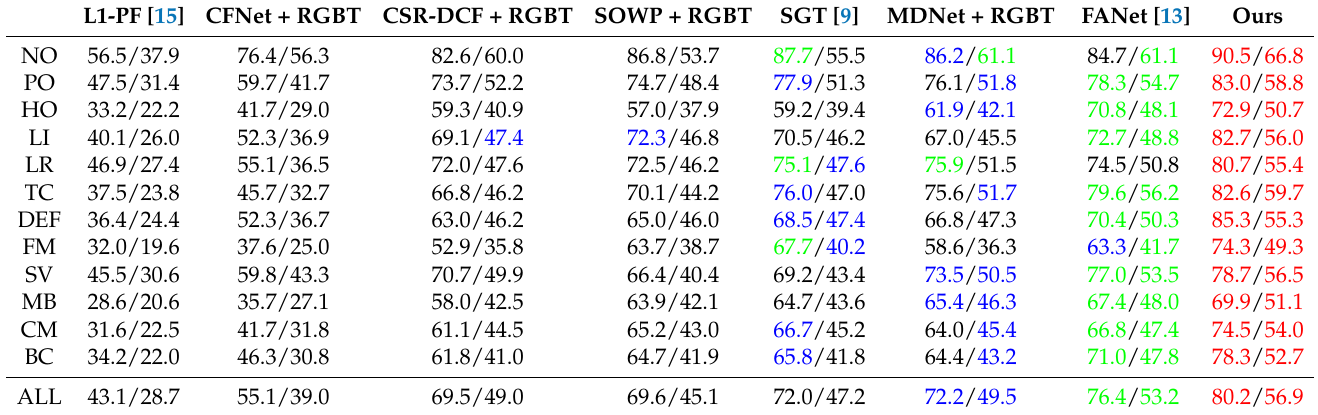
Table 1. Attribute-based PR/SR score ( % ) on the RGBT234 dataset against other RGB-T trackers.